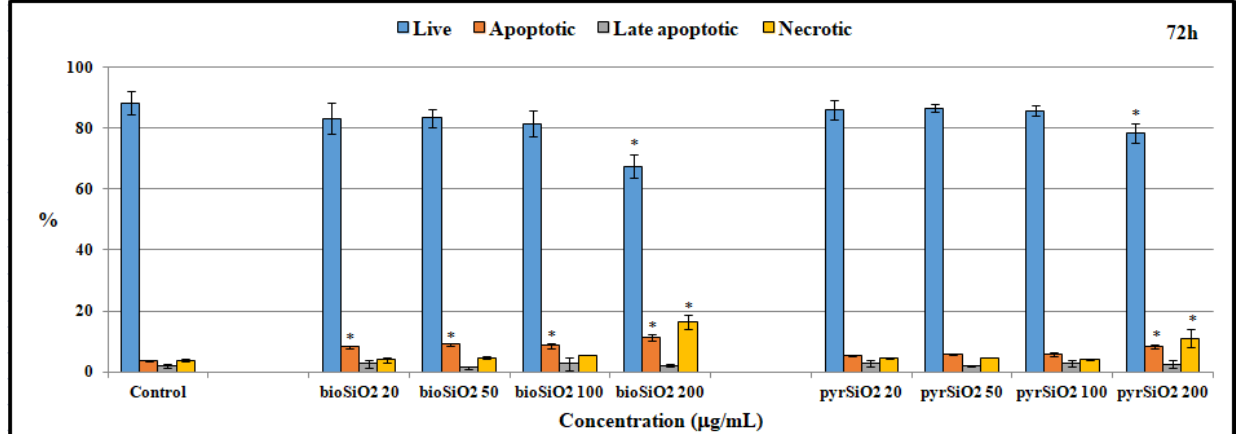
Figure 8. Occurrence of apoptosis, late apoptosis, and necrosis in cells with silica nanoparticles (0–200 μg/mL) after 72 h of incubation. Statistical evaluation of differences was conducted using the ANOVA I and Tukey’s post hoc tests, at significance levels of p < 0.01 (*) with respect to control.